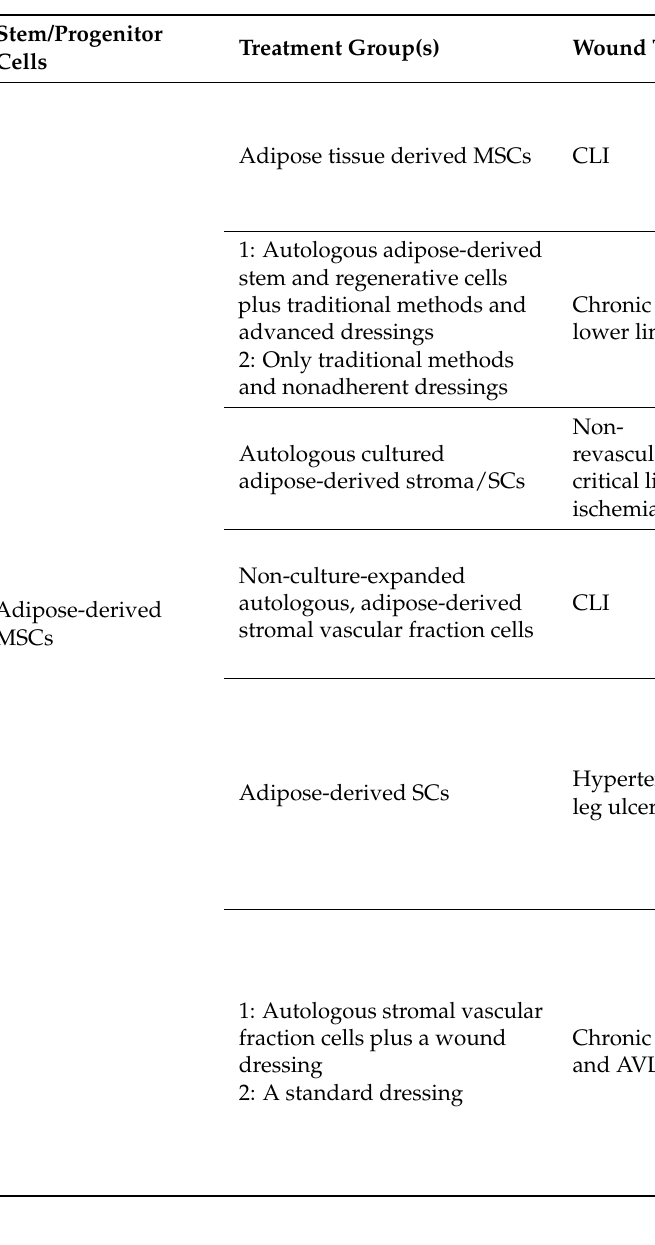
Table 1. Clinical studies on stem/progenitor cell-based therapy for wound healing.